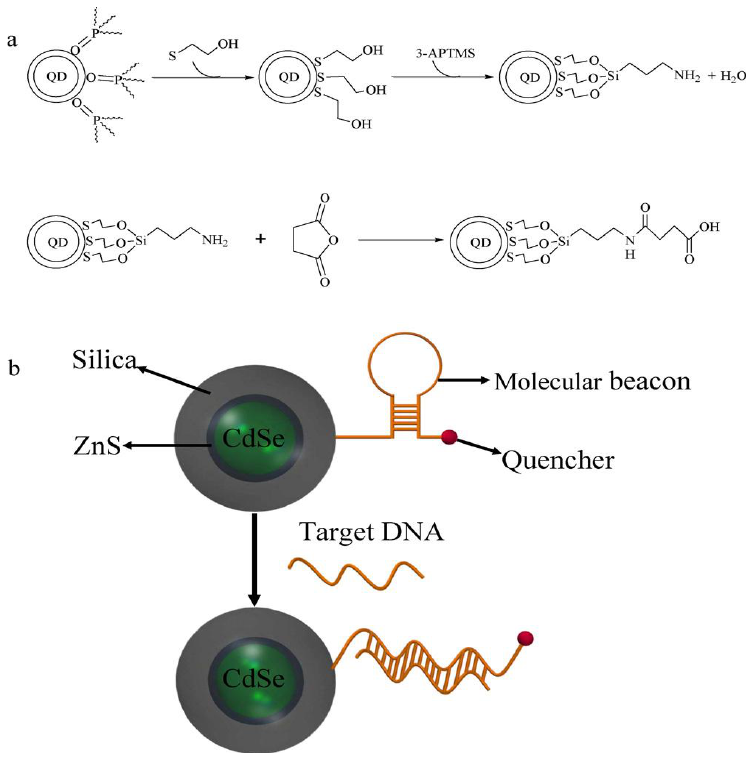
Figure 10. ( a ) Reaction scheme of the silanization and functionalization of QDs ( b ) Schematic of a QD based molecular beacon. Reprinted with permission from [55], © 2011